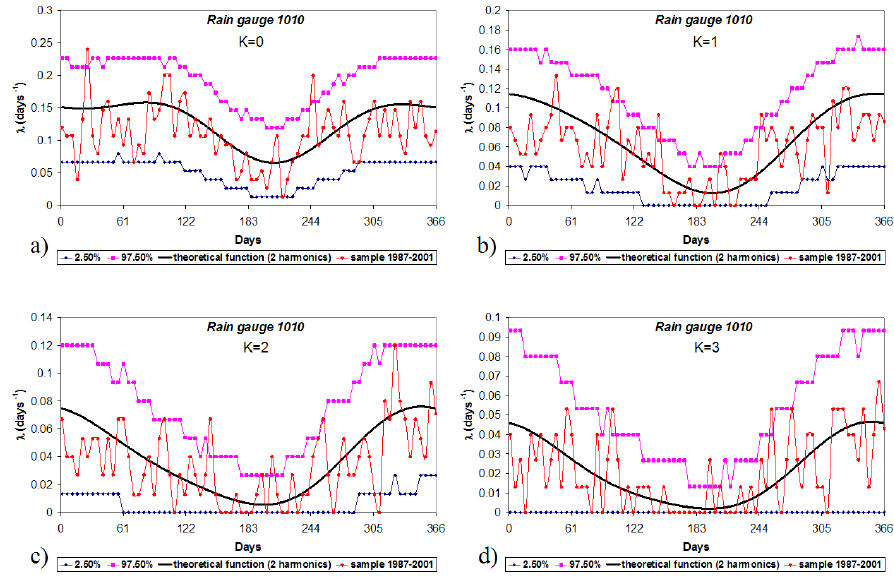
Fig. 8. Cosenza rain gauge: confidence interval of sample intensity function λ(t) referred to the validation period for K = 0 (a) , K = 1 (b) , K = 2 (c) and K = 3 (d) .